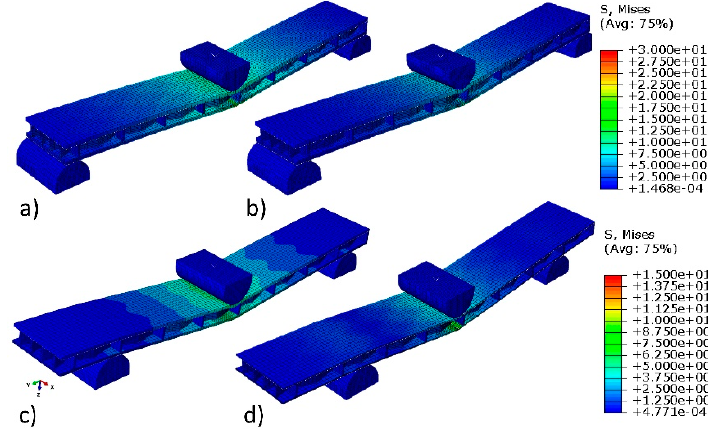
Figure 9. Examples of beams’ deflection: ( a ) PL(L), ( b ) PL(R), ( c ) HDF, and ( d ) CA.